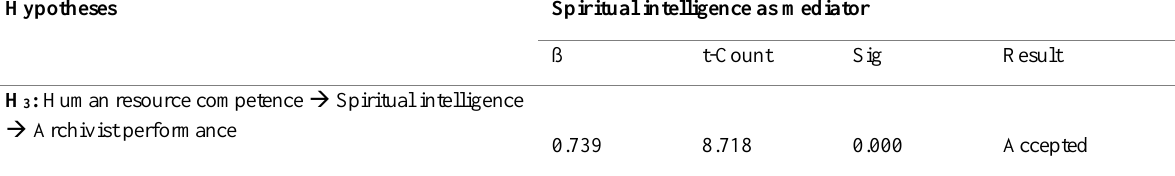
Table 4 : Mediation